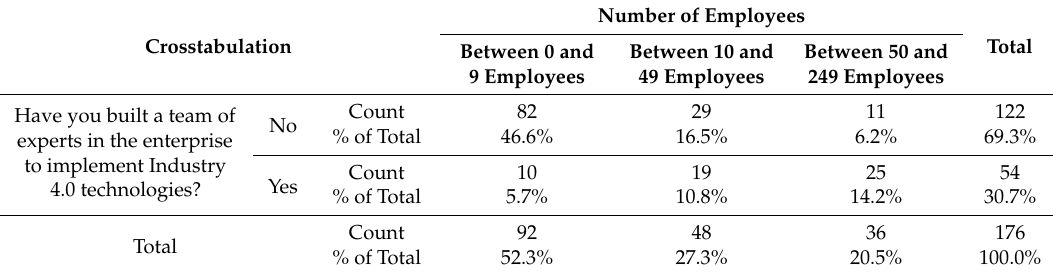
Table 9. Table of contingency on the extent to which SMEs have built digitization expert teams in relation to the size of the